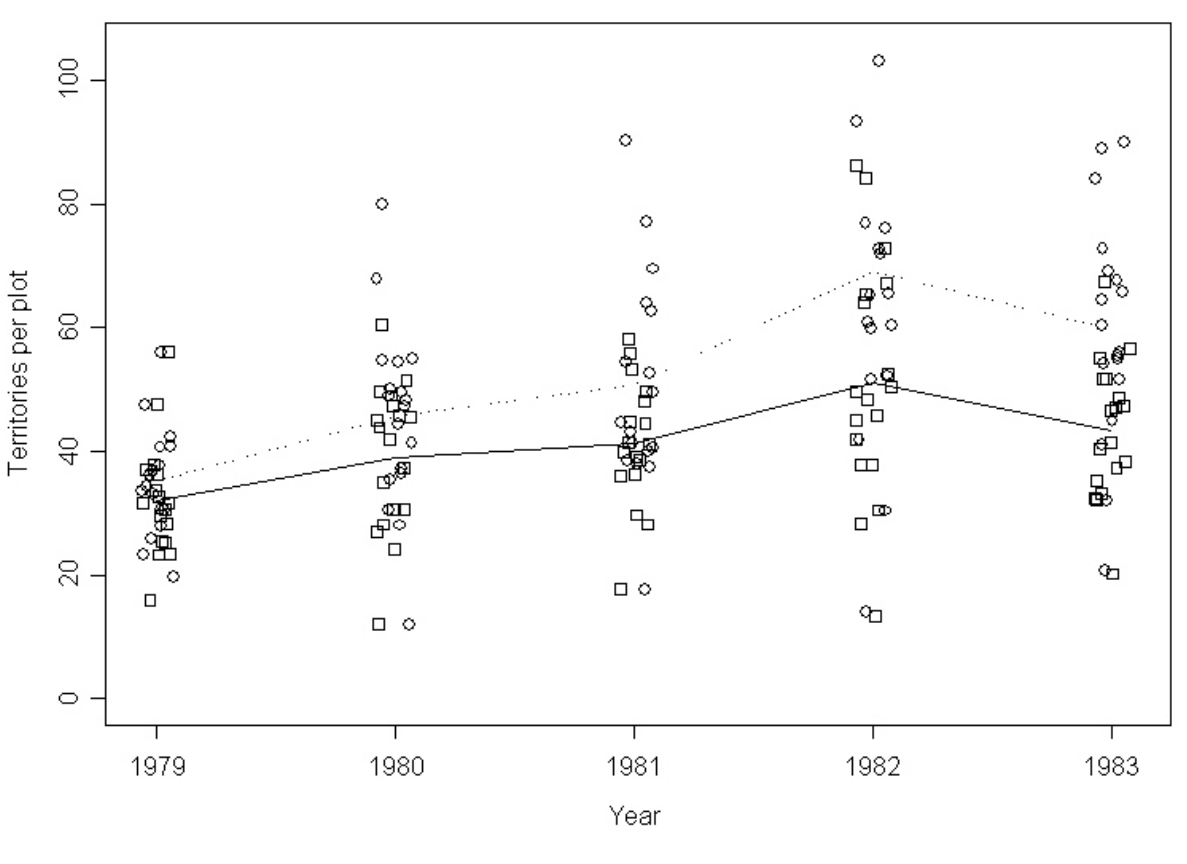
Fig. 5 . Mean number of territories per plot for all species (circles, dotted line represents means), and for all species except Bay-breasted Warbler ( Dendroica castanea ), Tennessee Warbler ( Vermivora peregrina ), and Cape May Warbler ( Dendroica tigrina ; squares, solid line represents